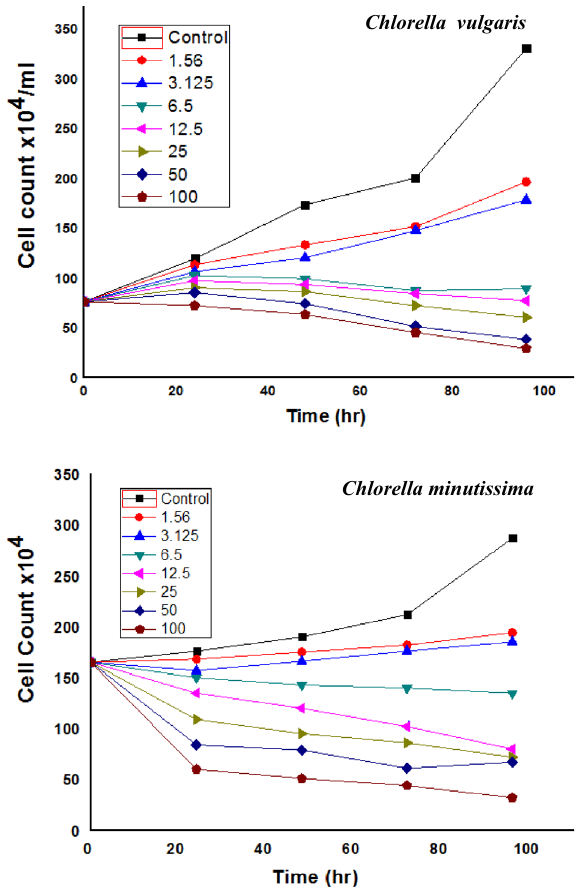
Figure 6. Effect of different concentrations of silver nanoparticles (OG-AgNPs) (100, 50, 25, 12.5, 6.5, 3.125, 1.5 and 0 μg/mL) on the growth of Chlorella vulgaris and Chlorella minutissima along the incubation period (24 h. interval) for 96 h (data are mean ± standard